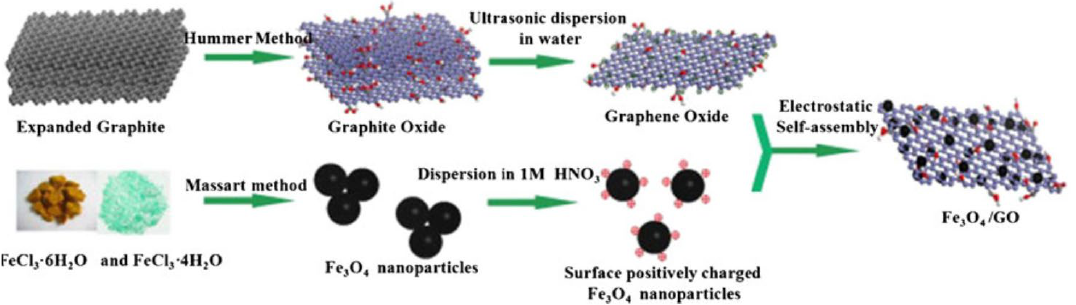
Fig. 6. Schematic illustration of fabrication of the Fe Fig. 6 Schematic illustration of fabrication of the Fe 3 O 4 -GO nanocomposite [67].